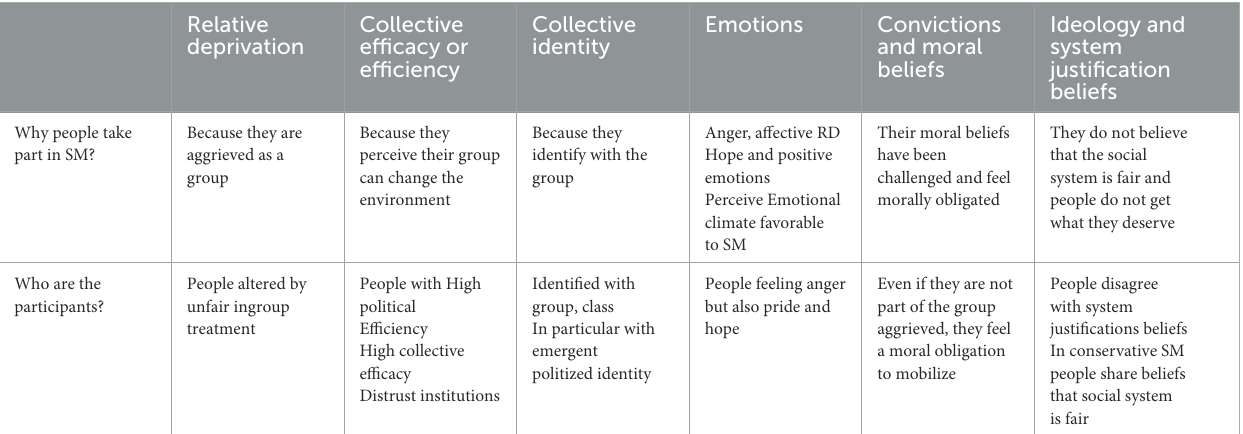
TABLE 2 Explanatory factors of CB and